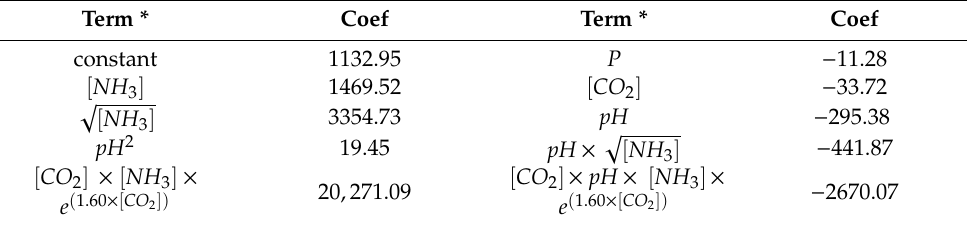
Table 8. Coe ffi cient table for the equation obtained by GP.